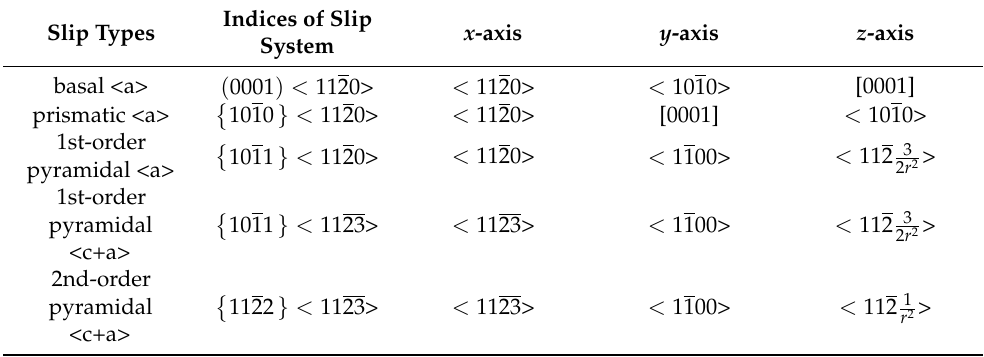
Table 2. The x , y and z axes of the slip reference frame for different slip systems in hcp metals 1 .